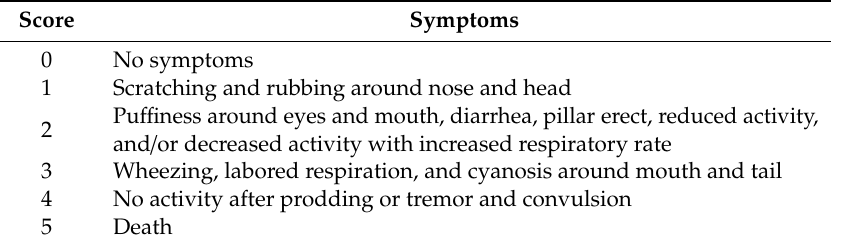
Table 2. Symptom score after